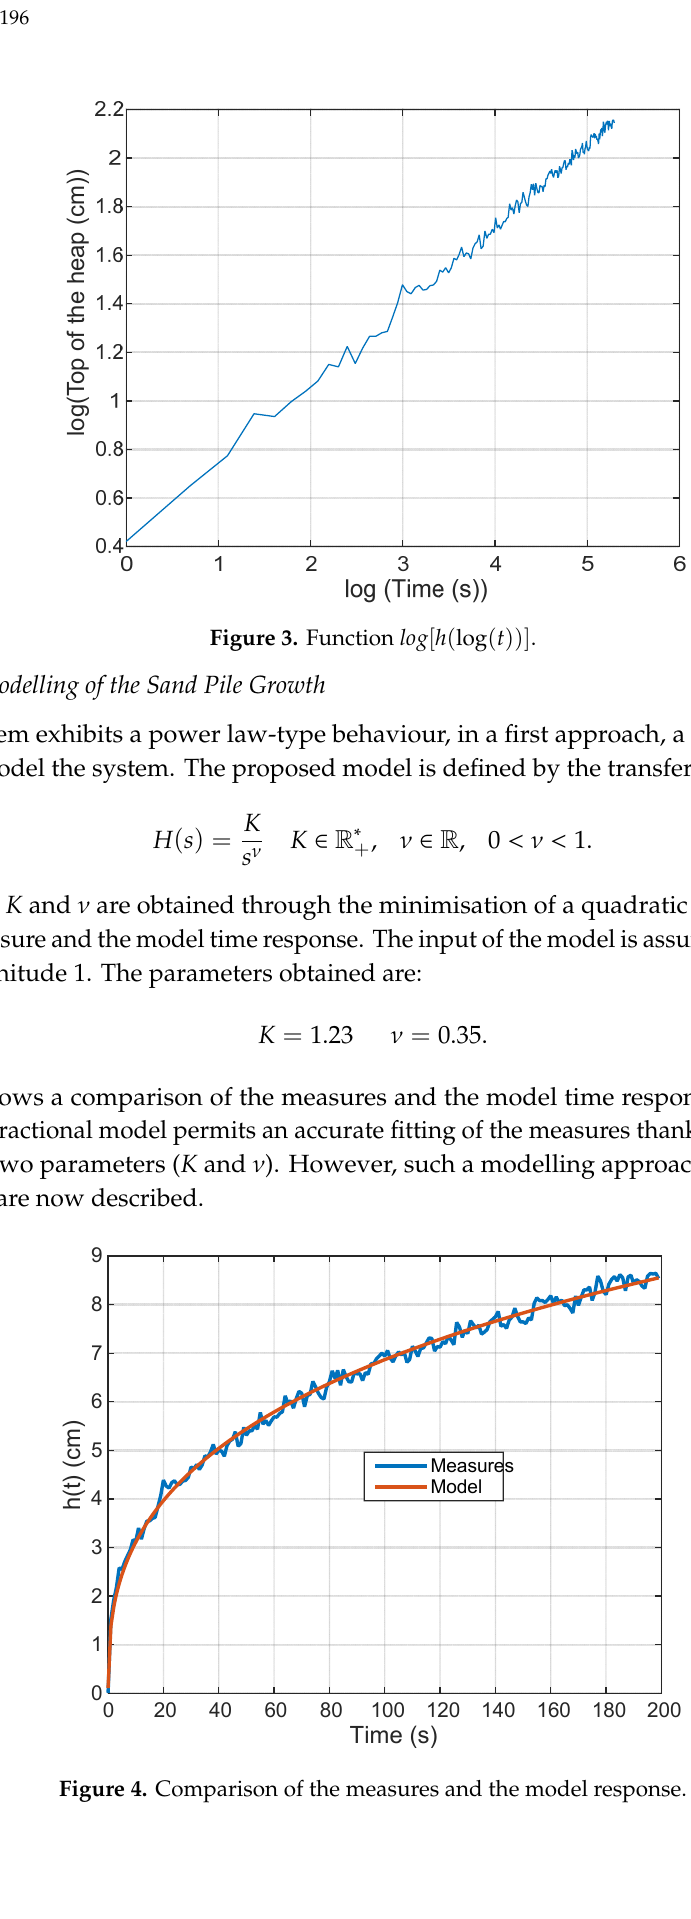
Figure 2. Heap top ℎ(cid:4666)𝑡(cid:4667) variation.